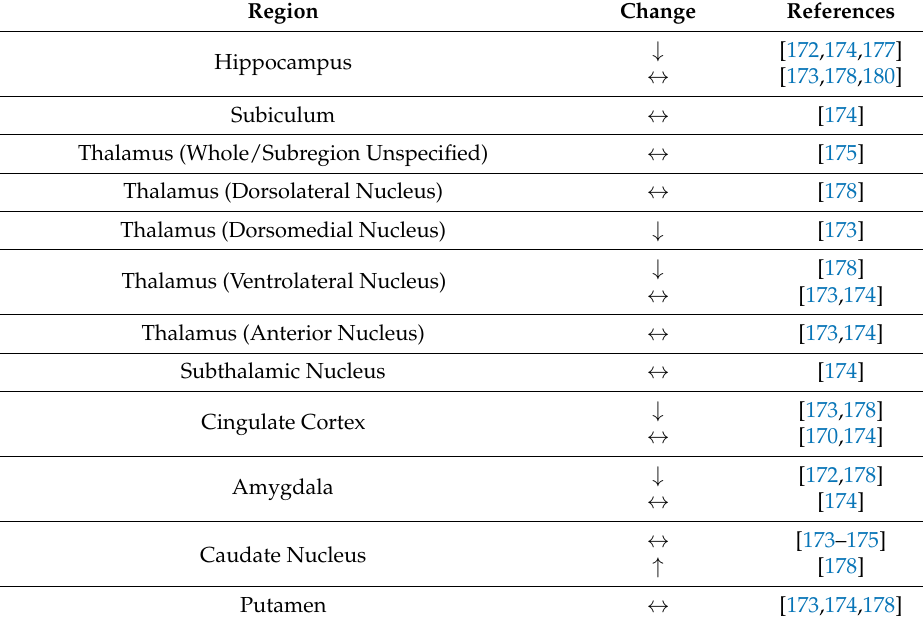
Table 1. Changes in GABA levels in the human Alzheimer’s disease